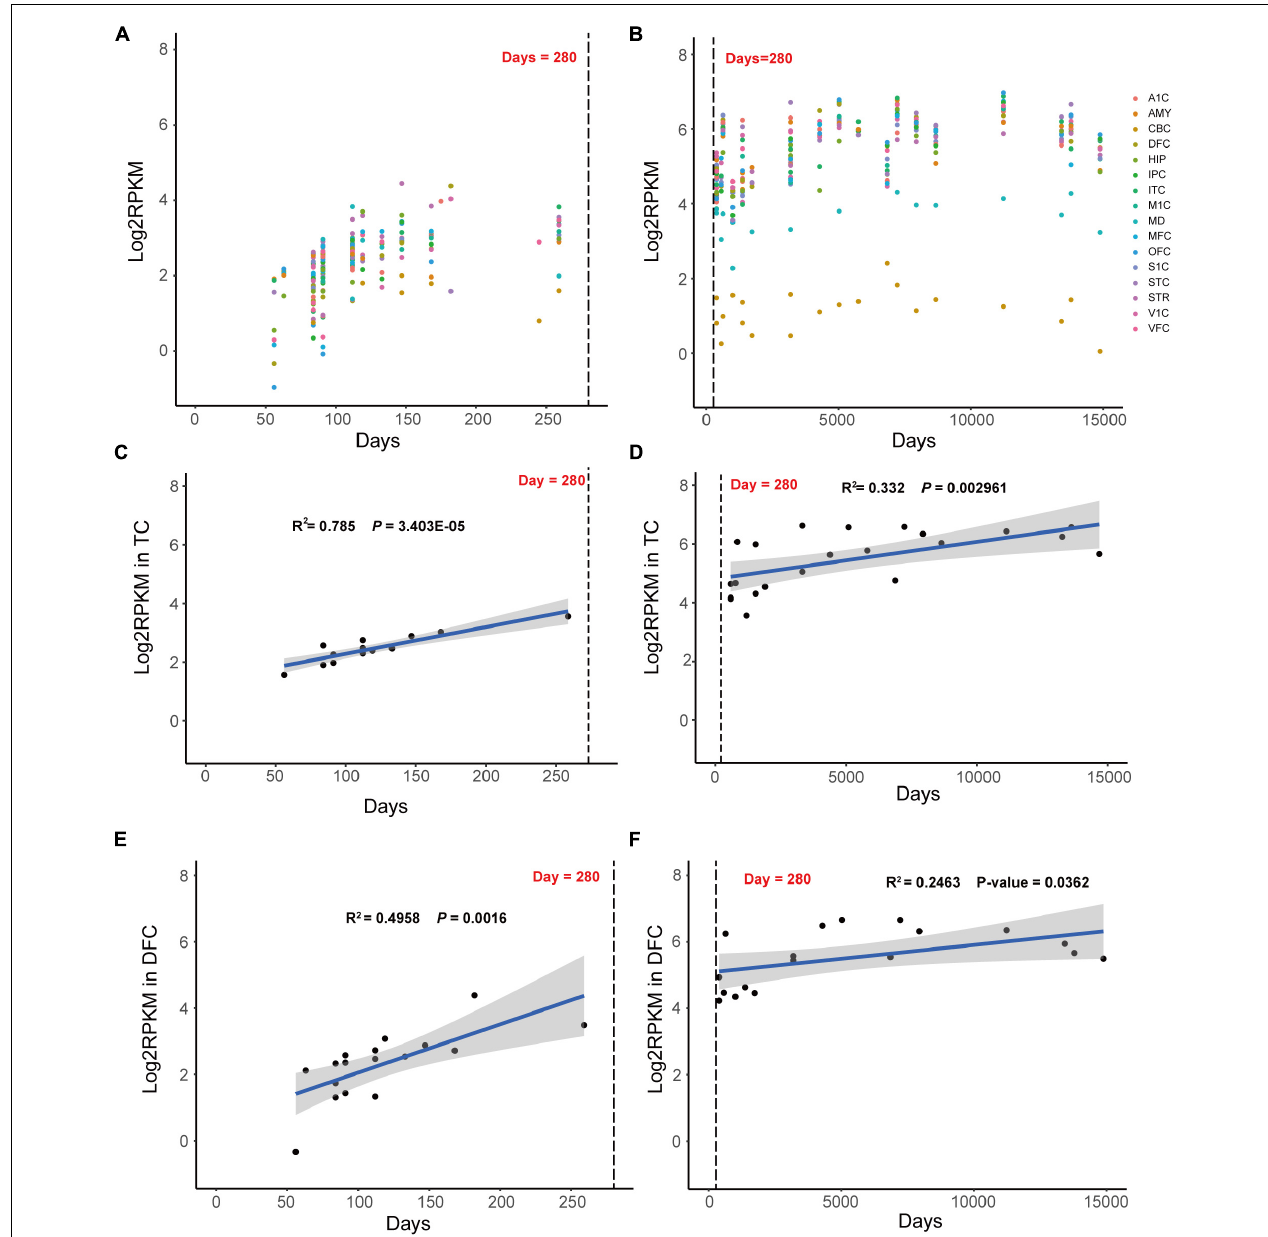
FIGURE 3 | Dynamic expression mode of MAST3 in human development brains. (A,B) Expression of MAST3 during brain development periods in different brain regions. The x -axis is the age of samples in days and y -axis is the log2-transformed RPKM of MAST3 . A1C, primary auditory cortex; AMY, amygdaloid complex; CBC, cerebellar cortex; DFC, dorsolateral prefrontal cortex; HIP, hippocampus; IPC, inferior parietal cortex; ITC, inferolateral temporal cortex; M1C, primary motor cortex; MD, mediodorsal nucleus of thalamus; MFC, medial prefrontal cortex; OFC, orbital frontal cortex; S1C, primary somatosensory cortex; STC, superior temporal cortex; STR, striatum; V1C, primary visual cortex; VFC, ventrolateral prefrontal cortex. The dashed line indicates the birthday. (C,D) Expression of MAST3 in the TC region. (E,F) Expression of MAST3 in the DFC region. Univariate regression analysis was applied in prenatal brains (left) and post-natal brains (right), separately. Blue line represents the regression line and the gray region indicates 95% CI. The text shows the R 2 and P -value of